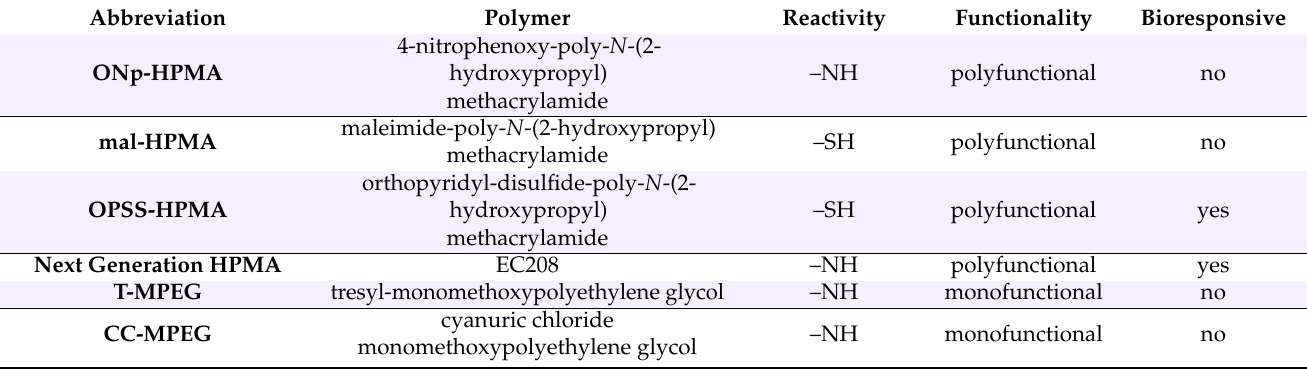
Table 1. Overview of the discussed shielding polymers and their main characteristics. Reactivity of the polymers was directed to amine- (–NH) or thiol- (–SH) groups, whereas the functionality describes the number of reactive groups per polymer (monofunctional = one reactive group; heterobifunctional = two different reactive groups; polyfunctional = many reactive groups). Bioresponsive polymers were coupled reversible (under physiological conditions) to the